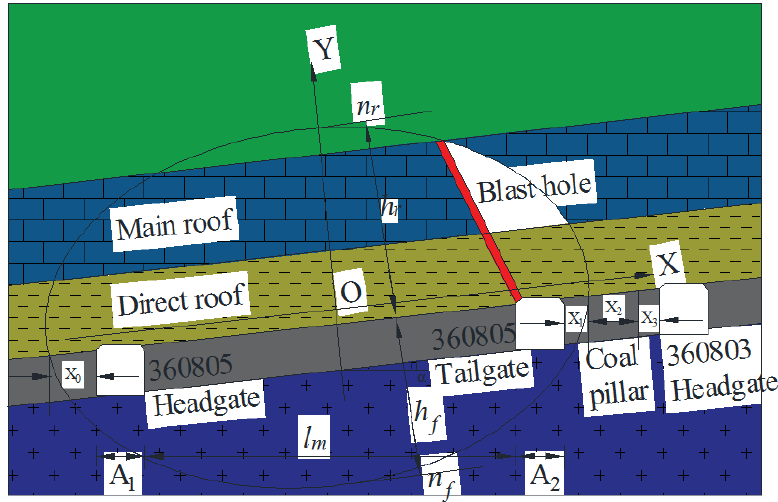
Figure 2. Dip section along the 360,805 working face.